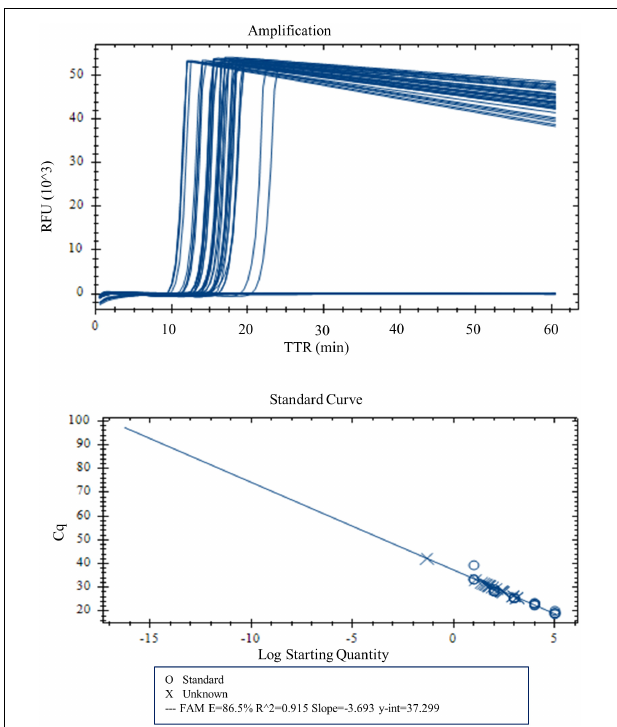
FIGURE 3 | Amplification and standard curve with DNA concentrations 100, 50, 10, 5, 1, 0.5, 0.1, 0.05, 0.04, 0.03, 0.02, 0.01, and 0.005 pg. Four replicates were tested for each concentration. Four of four replicates were amplified for DNA concentrations 100–0.03 pg. TTR was negatively correlated to the DNA concentrations.